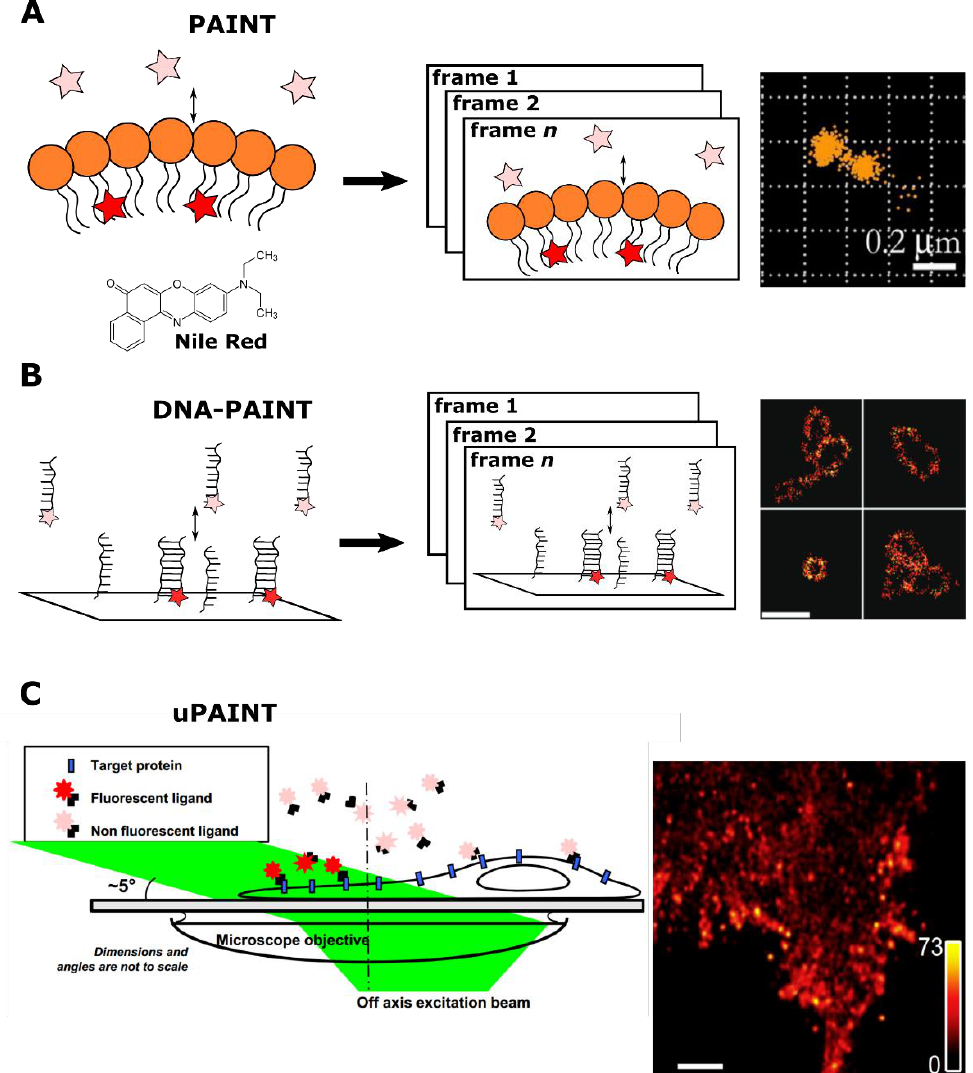
Figure 2. A schematic illustration of PAINT methods. ( A ) An original PAINT approach. Left: an environment-sensitive probe (Nile Red) fluorescently bursts upon reversible interaction with the lipid layer. Center: accumulation of fluorescent bursts during n frames registration. Right: the reconstructed image of vesicles, imaged with PAINT approach using Nile Red probe. Reprinted from Sharonov et al. [26] (copyright (2006) National Academy of Sciences). ( B ) A DNA-PAINT approach. Left: in the DNA-PAINT labeling system target and dye molecules are conjugated to complementary DNA strands. Transient interaction between strands temporarily co-localizes fluorescent probes with a target structure. This binding event is detected as a burst of fluorescence. Center: accumulation of fluorescent bursts during n frames registration. Right: reconstructed images of long rectangular DNA-origami oligomers labeled with DNA-PAINT. Scale bar 500 nm. Reprinted with permission from Jungmann et al. [30]. Copyright (2010) American Chemical Society. ( C ) A uPAINT approach. Left: fluorescent probes bind to target sites in the cell. A low-angle excitation laser beam (angle of about 5 ◦ ) illuminates ≈ 2 µ m thick cross section, thereby excites predominantly only bound labels. Right: Super-resolved image of the transmembrane protein TM-6His labeled with trisNTA-AT647N obtained by uPAINT. Scale bar 1 µ m. Reprinted from Giannone et al. [31], copyright (2010), with permission from Elsevier.